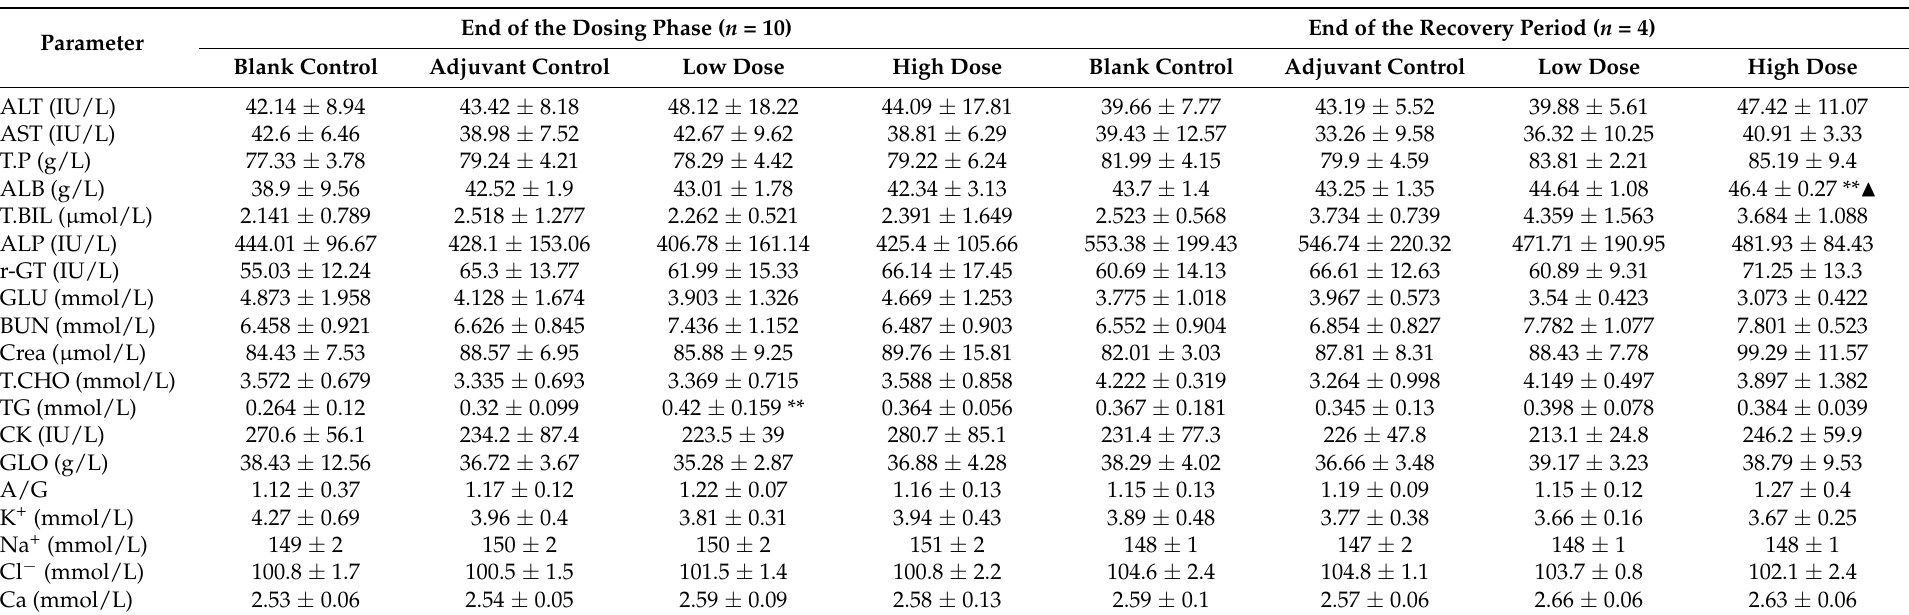
Table 2. The blood biochemistry analysis in cynomolgus macaques treated with ZF001 vaccines in repeat-dose toxicity